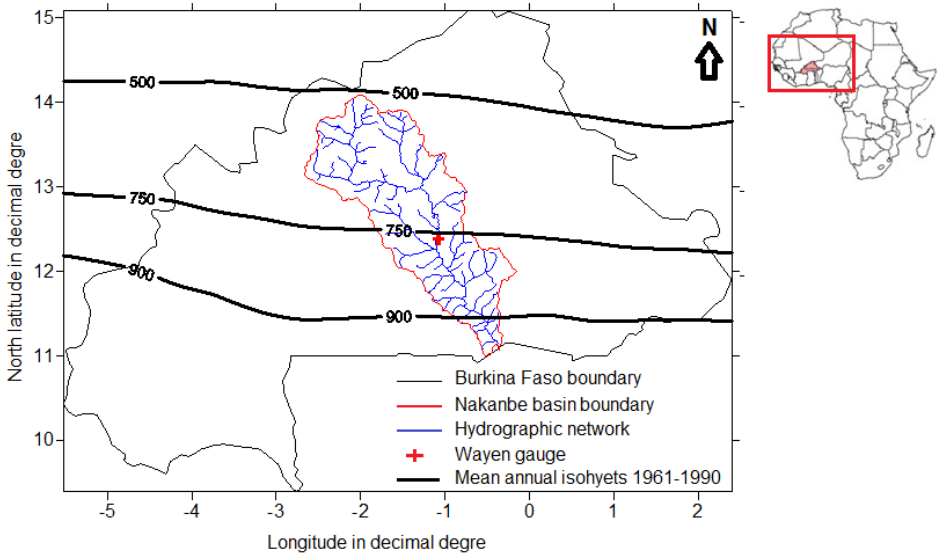
Figure 1. Geographical position of Nakanbe basin in Burkina Faso. The isohyets